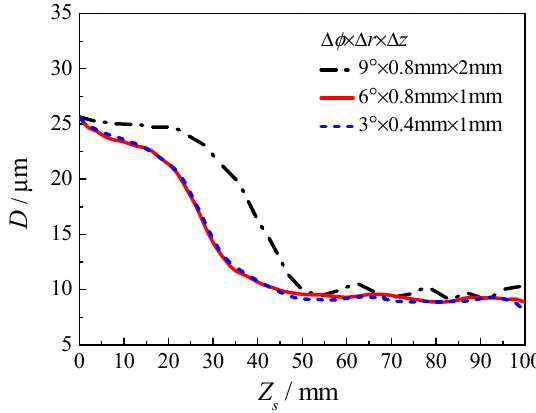
Figure 3. Flowchart of present simulation.